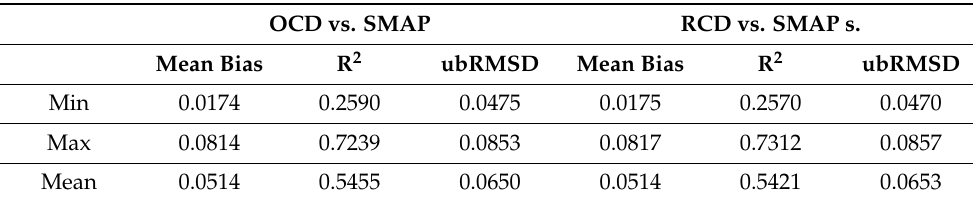
Figure 10. Validation of soil moisture retrieved using OCD (green line) and RCD (red line) based on SMAP product. Table 3. Summary of the average validation indicators of soil moisture retrieval based on SMAP soil moisture